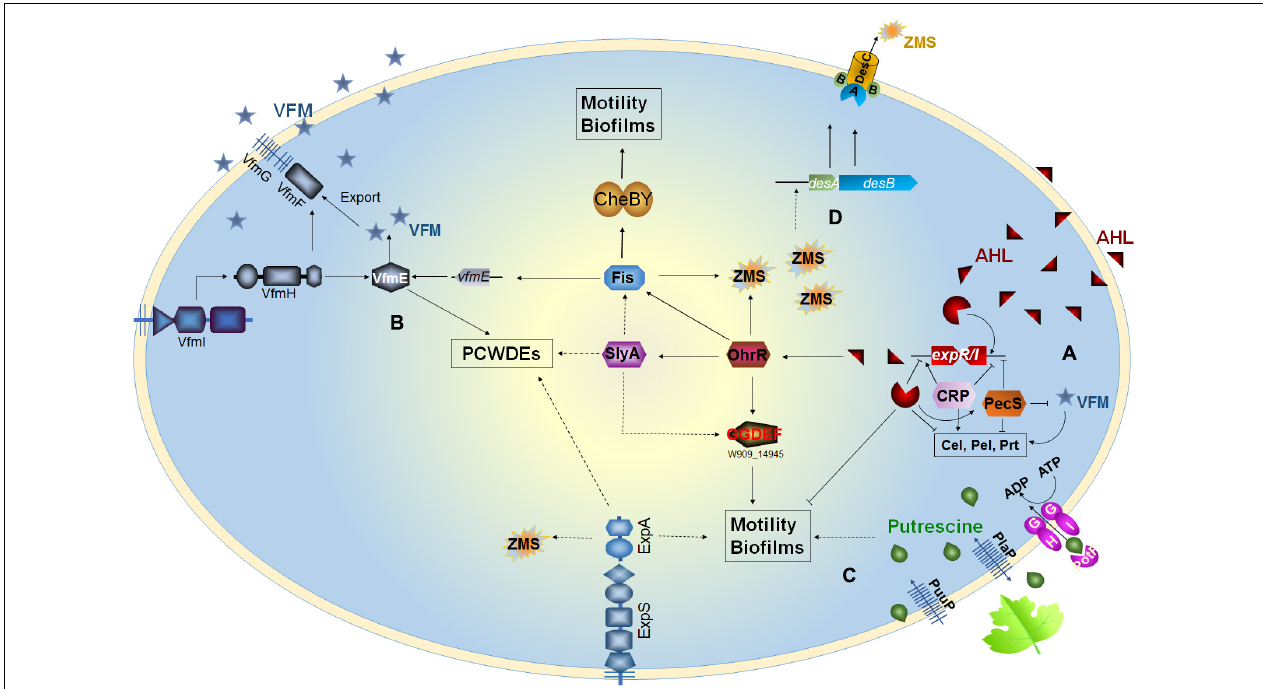
FIGURE 1 | Regulatory pathways of the quorum sensing (QS) systems in Dickeya . (A) Dickeya bacteria produce AHL QS signal to regulate cell motility and biofilm formation; (B) VFM QS signal modulates the production of PCWDEs in Dickeya ; (C) Putrescine is a transkingdom communication signal modulating cell motillity and biofilm formation; (D) Zeamines regulate the DesAB efflux